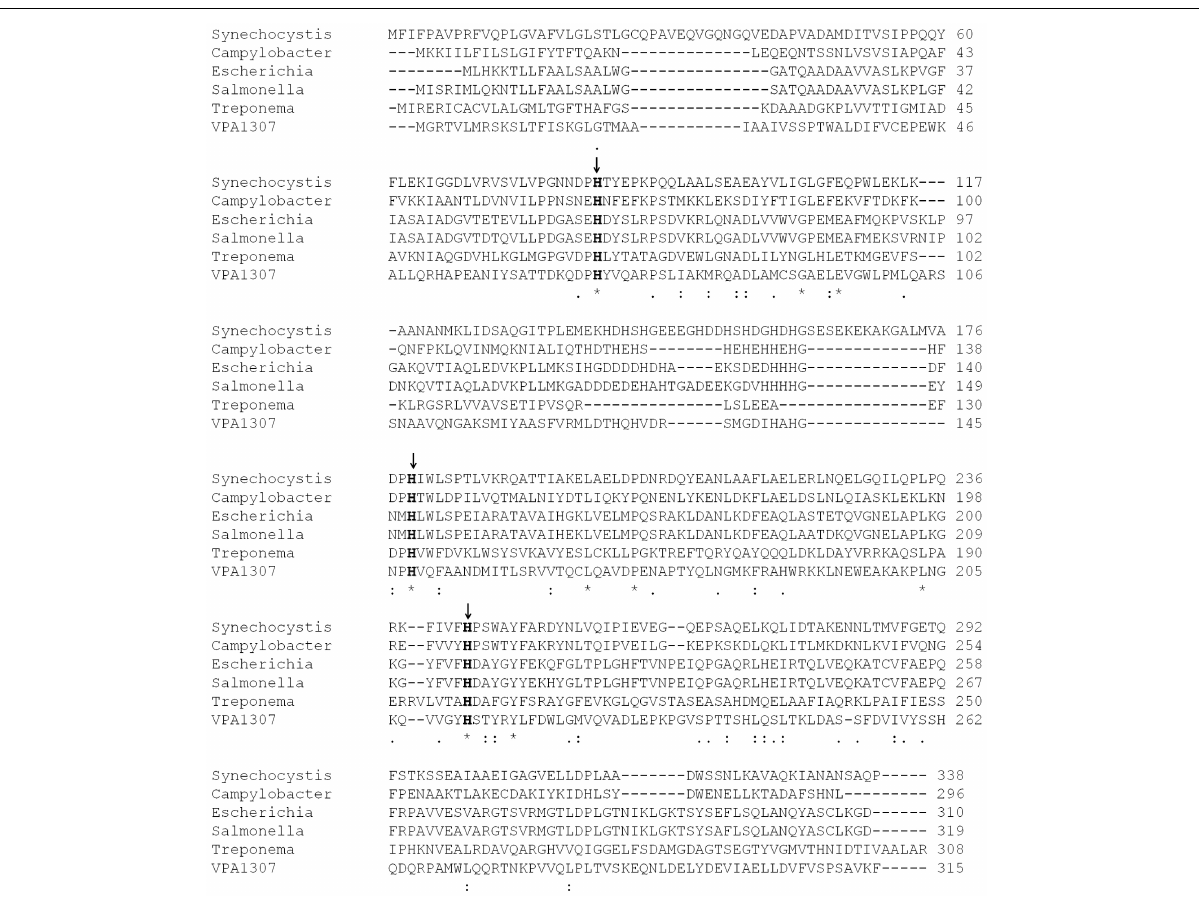
Synechocystis sp., E. coli , S. enterica , Treponema pallidum, and V. parahaemolyticus , respectively) were aligned using the CLUSTAL W2. Three conserved histidine residues were indicated by black arrows.